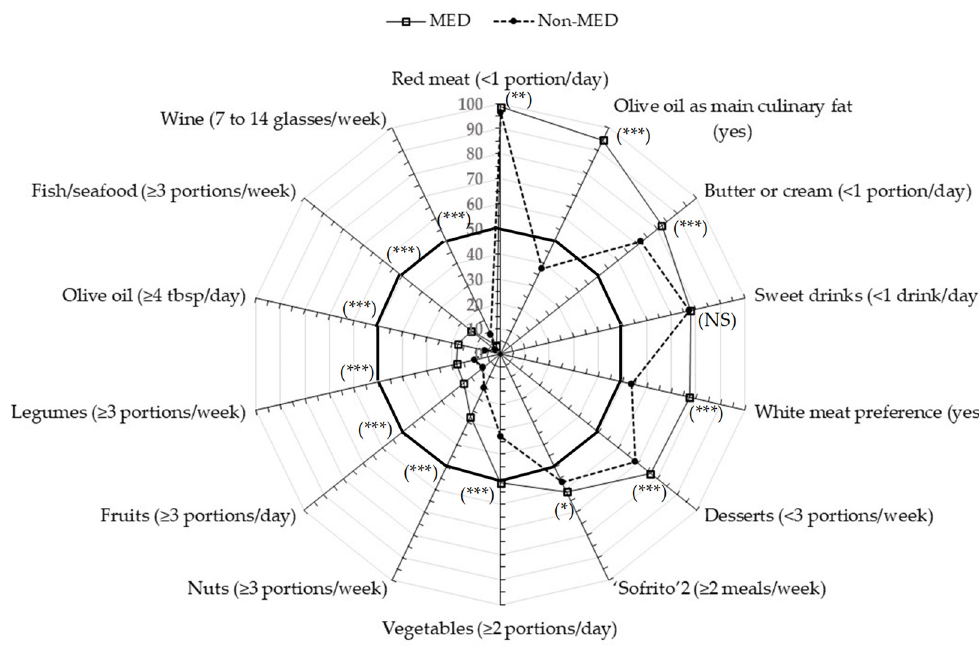
Figure 2. Rank-ordered radar plot of the food items included in the 14-MEDAS score comparing the choices between the MED group of countries and the non-MED group. Data represents the percentage of participants in each group scoring 1 for each question (within the Mediterranean diet adherence recommendation). Dark intermediate circle represents the 50% point. NS: not significant; * p -value < 0.05; ** p -value < 0.01, *** p -value < 0.001.